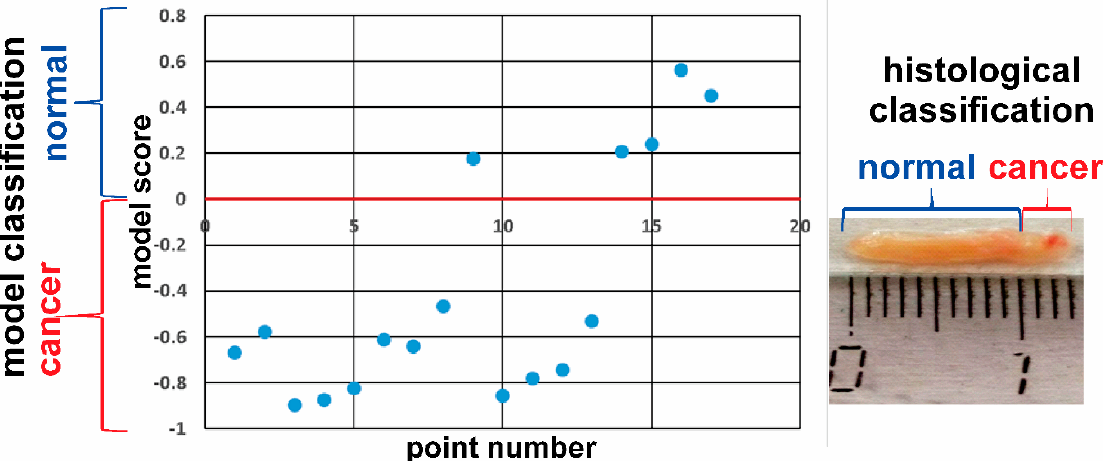
Figure 7. The plot of tissue classification score vs. its spatial position. The scores were obtained by unsupervised analysis of LTEU-EESI-MS mass spectra with the developed OPLS-DA model. The figures in the photo indicate several points for which histological and LTEU-EESI-MS analyses were done. The figures are colored according to histological results, with blue color corresponding to normal tissue and red color corresponding to cancer tissue. The red line on the graph was determined by statistical model and separates “normal region” from “cancer region”.